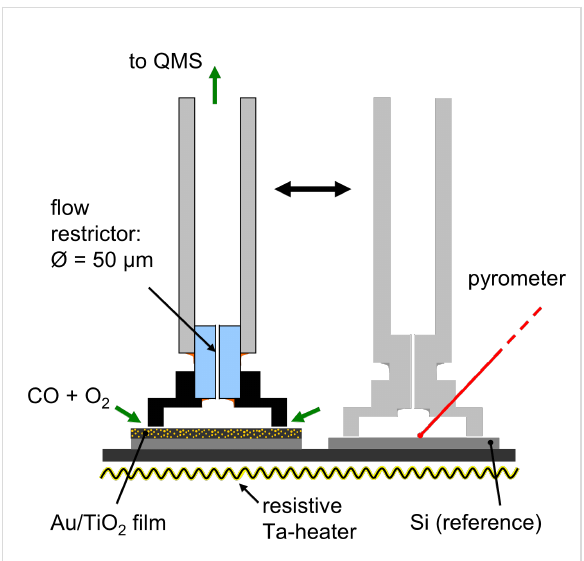
Figure 1: Schematic drawing of the end of the SMS capillary and the sample in the scanning mass spectrometer. Lower part: Sample holder with resistive heater and two separate samples (here: Au/TiO 2 film on Si and a catalytically inactive Si wafer), upper part: Capillary with flow constriction (can be moved from one sample to the next one).